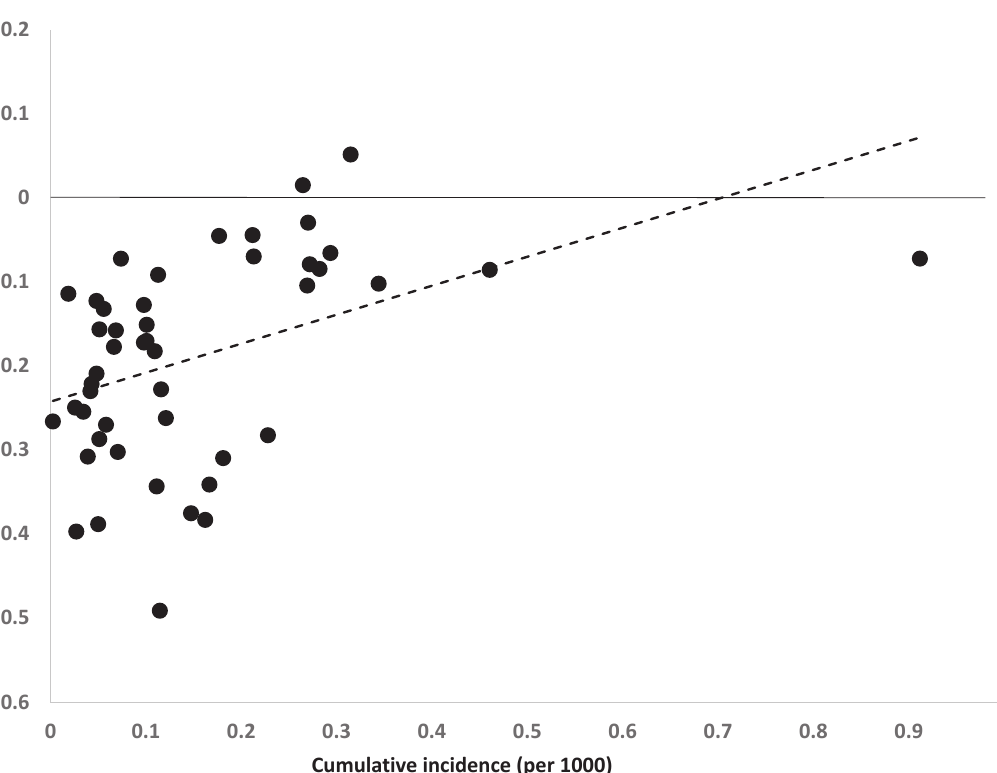
Figure 2. Cumulative number of patients with COVID-19 in Japan until July 2020, and excess mortality from January to July 2020 in each